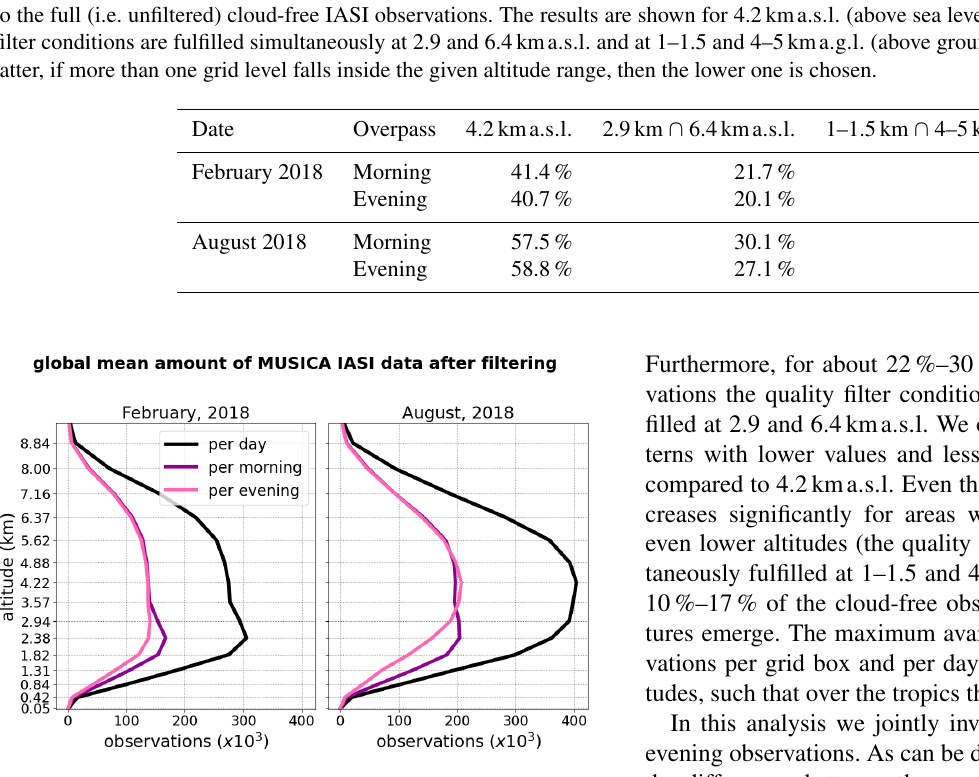
Figure 8. Averaged number of quality filtered {H 2 O, δ D} pairs for the tropospheric retrieval grid altitudes during February and August 2018. The black line indicates the global means that are further di- vided into the means for morning (violet) and evening (pink) over-